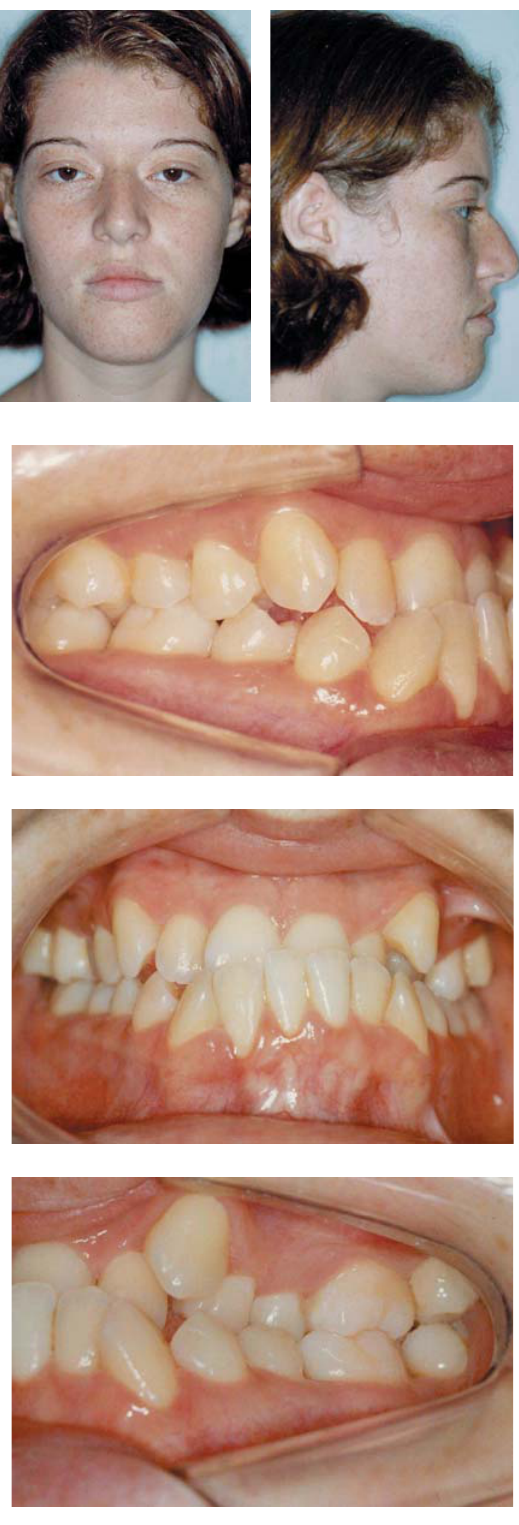
FIGURE 1- Pretreatment facial and intraoral photographs (patient signed informed consent authorizing the publication of these